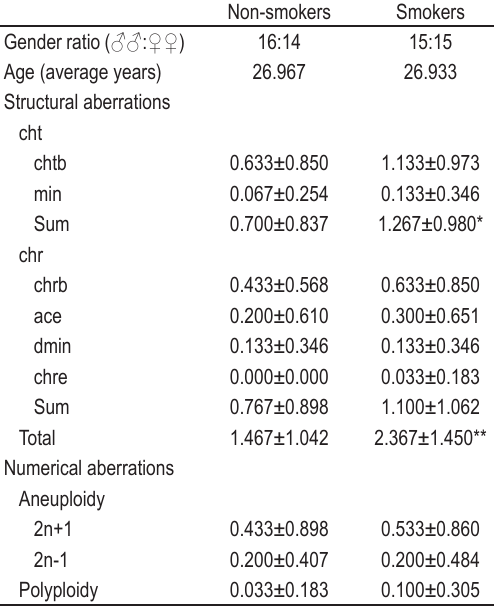
TABLE 2. Frequencies of observed chromosome aberrations